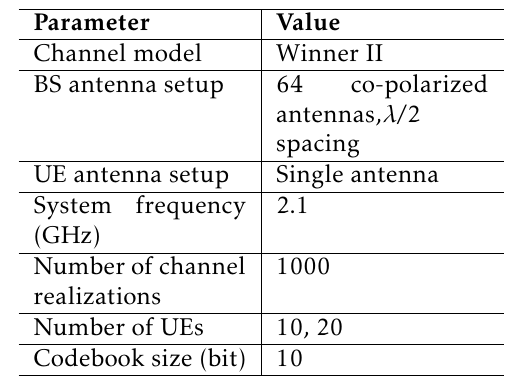
Table 1. Parameters Configuration